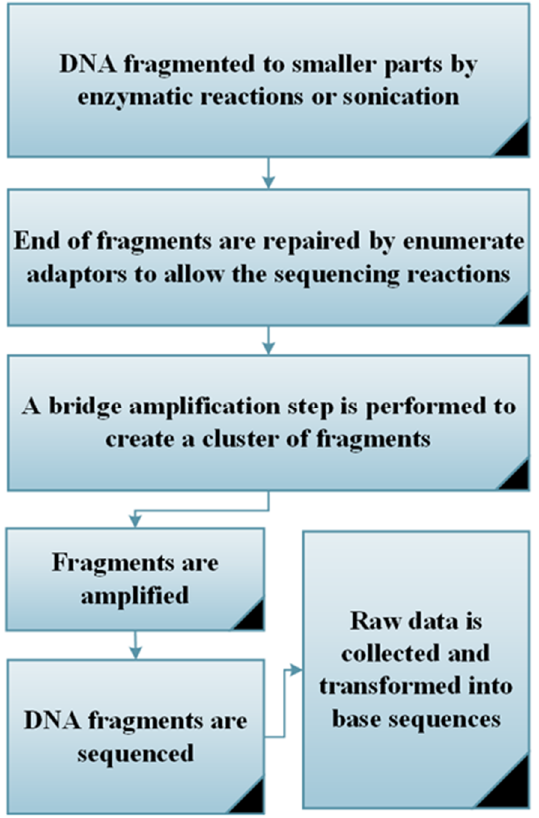
Figure 2. The 6 main steps for conducting a next-generation sequencing (NGS) approach.